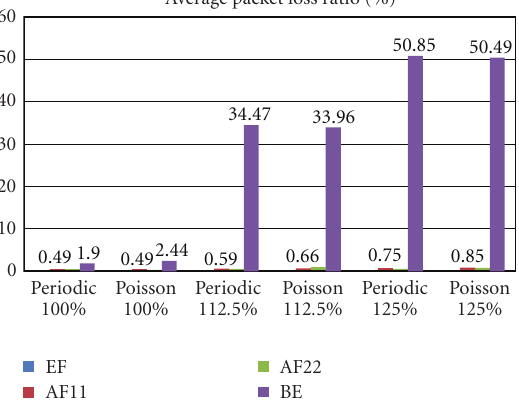
Figure 12: Average delay variation.